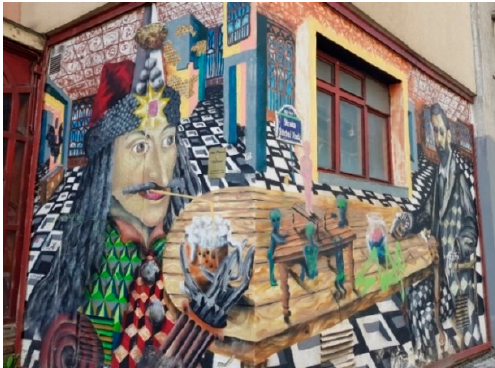
Figure 38. Vlad Ț epes and Bram Stoker, Ș tirbei Vod ă st., Bucharest by Obie Platon, 2014 (photo taken in 2022). in